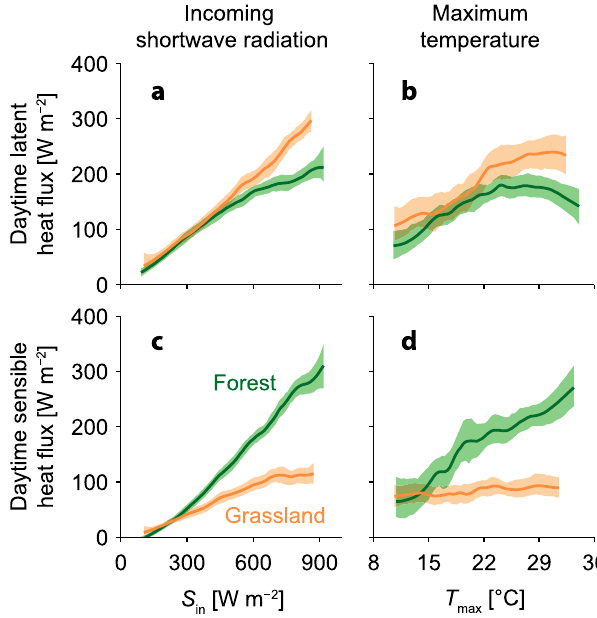
Figure 1. Observed midday sensible heat fluxes H (a) and latent heat fluxes LE (b) over forest and grassland sites as a function of daily maximum air temperature and averaged incoming shortwave radiation. Curves have been derived using locally weighted polyno- mial regression (LOESS) on all midday data (09:00–13:00UTC), heatwave days included, in the months June–August for all Euro- pean FLUXNET sites analyzed in T10. Uncertainty bounds reflect 5 and 95% percentiles of the LOESS regression as determined by bootstrapping. See supplementary information in T10 for more in-